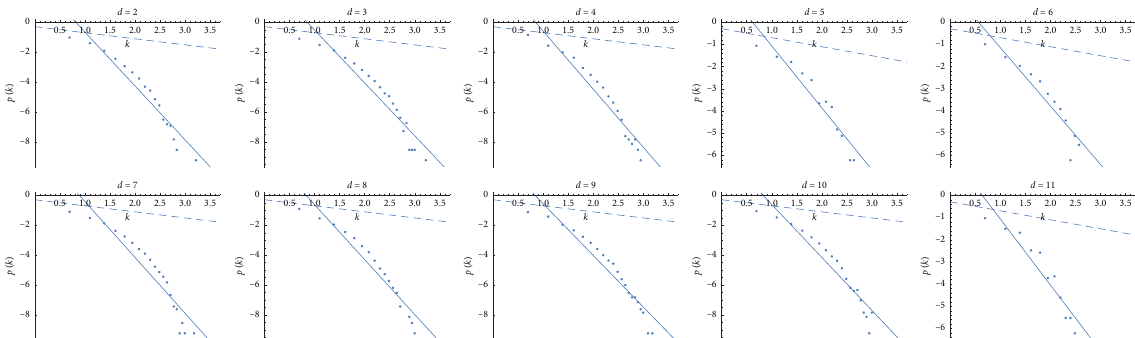
Figure 2: The degree distribution found in the HV graphs (dots) and the corresponding fitted function Ak − c (solid line) for ( k ) � ( 1/3 )( 2/3 ) k − 2 was included just for comparison. d ∈ 2 , 3 , ... , 11 { } . The dotted line representing P rand Table 4: Values of A and c of the fitted degree distribution P ( k ) � Ak − c and the average degree 〈 k 〉 in function of d for the natural visibility algorithm employed for mapping x d ( n ) into graphs.